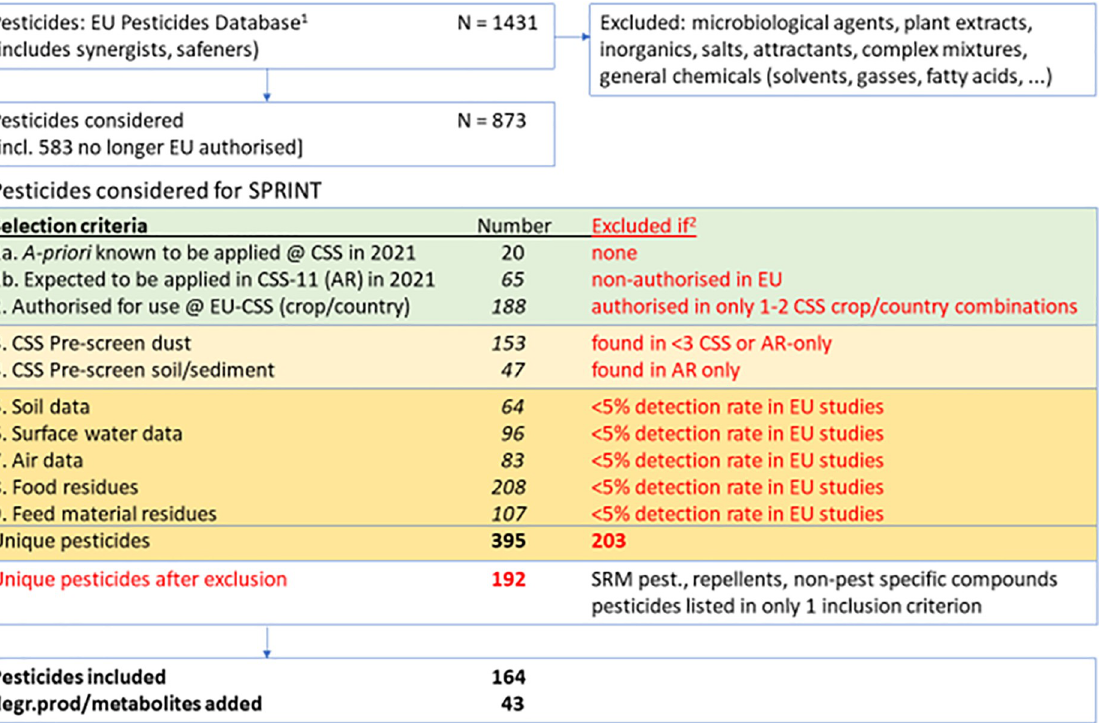
Fig 4. Selection of substances to be included in the analysis of environmental media, human and animal matrices. 1 Data retrieved in October 2020; 2 Excluded to bring the total number of substances down to approximately 200, amenable to multi-analyte methods. The reason for exclusion is indicated for each of the 9 selection criteria. SRM = Single Residue Method; AR = Argentina; degr./prod = degradation products.